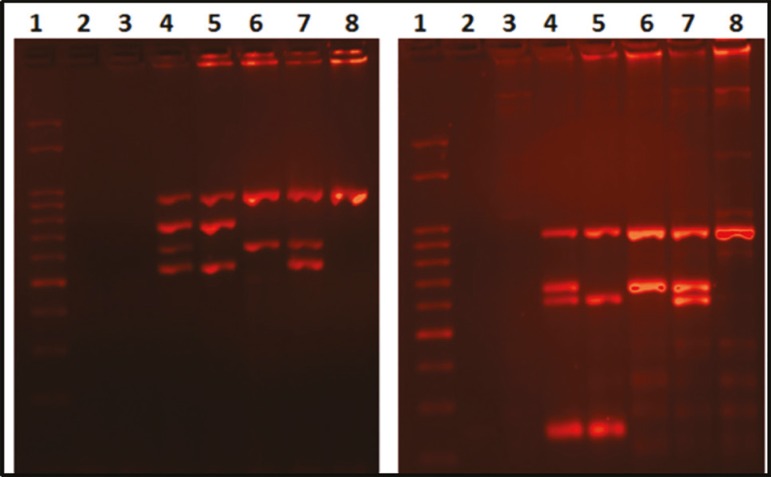
Y chromosome microdeletion analysis. Examples of both multiplex PCR. Lane 1: marker 50pb, lane 2: water, lane 3: female DNA, lane 4: DNA of a normal male, lane 5: DNA of AZFa deleted patient, lane 6: DNA of AZFbc deleted patient, lane 7: DNA of AZFc deleted patient and lane 8: DNA of AZFabc deleted patient